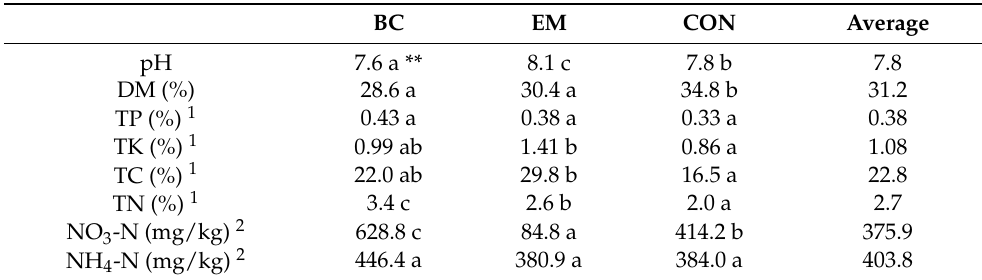
Table 4. Basic chemical characteristics of composts after seven months. AVE is the average value for a particular